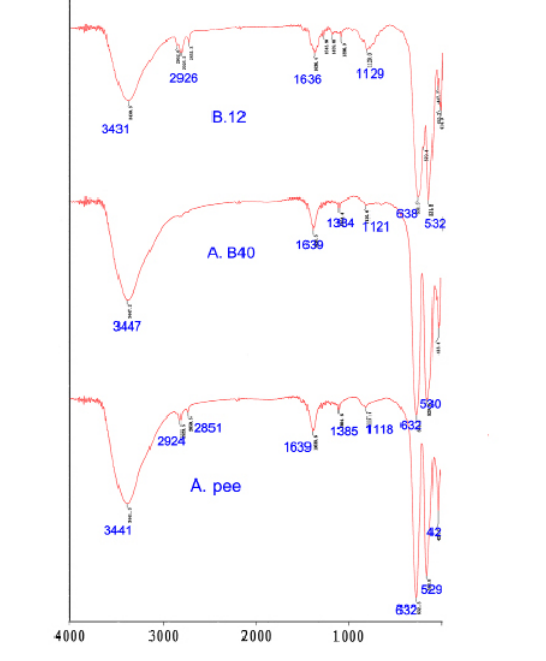
Figure 2. FTIR spectroscopy patterns of A.pee, A.B40,